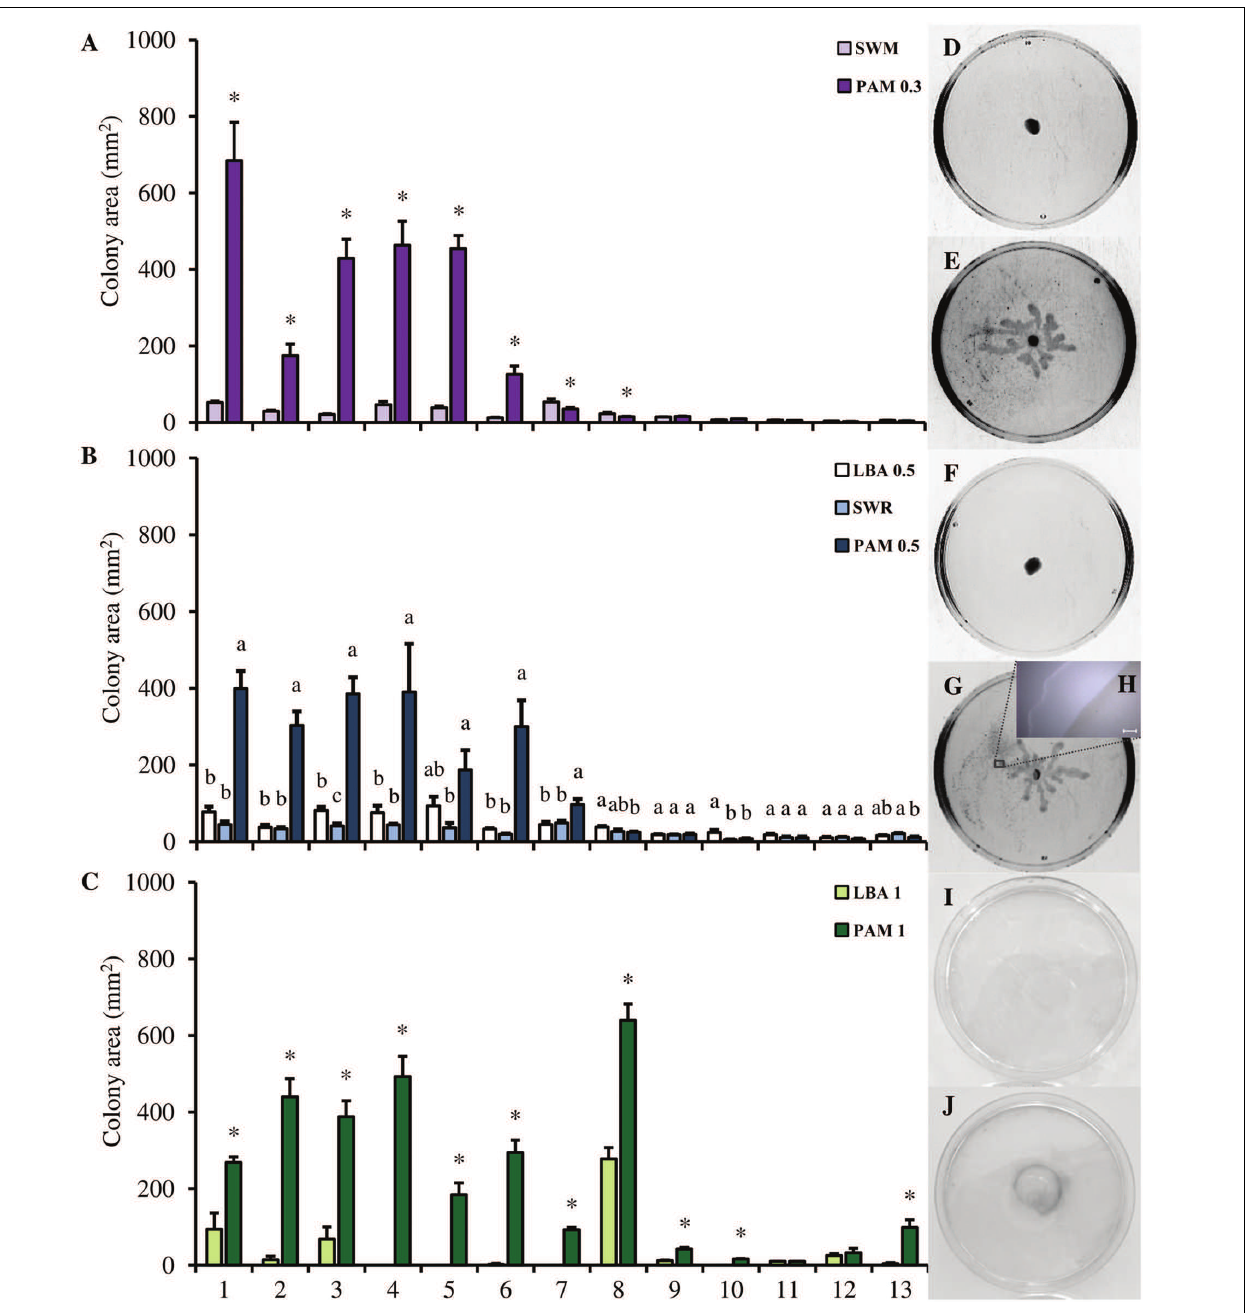
FIGURE 1 | Motility of the Lysobacter species on inert surfaces. The swimming (A) , swarming (B) and twitching (C) motility of the Lysobacter species (colony area, mm 2 ) was evaluated on Swimming Agar, (SWM), Pea Agar Medium 0.3 (PAM 0.3), Luria Bertani Agar 0.5 (LBA 0.5), Swarming agar (SWR), Pea Agar Medium 0.5 (PAM 0.5), Luria Bertani Agar 1 (LBA 1), and Pea Agar Medium 1 (PAM 1). An F -test revealed non-significant differences between experiments ( P values ranged from 0.12 to 0.81 for the motility assay) and data from the three experiments were pooled. Mean colony area and standard error values were calculated as the pool of nine replicates (Petri dishes) from three experiments. For each strain, asterisks indicate values that differ significantly according to Student’s t -test ( α = 0.05) in the pairwise comparison of SWM and PAM 0.3, and LBA 1 against PAM 1. In the swarming assay for each strain, different letters indicate significant differences according to Tukey’s test ( α = 0.05). 1, L. capsici AZ78; 2, L. capsici 55; 3, L. capsici 6.2.3.; 4, L. capsici DSM 19286 T ; 5, L. capsici DSM 23109; 6, L. capsici M143; 7, L. antibioticus DSM 2044 T ; 8, L. enzymogenes DSM 2043 T ; 9, L. daejeonensis DSM 17634 T ; 10, L. gummosus DSM 6980 T ; 11, L. brunescens